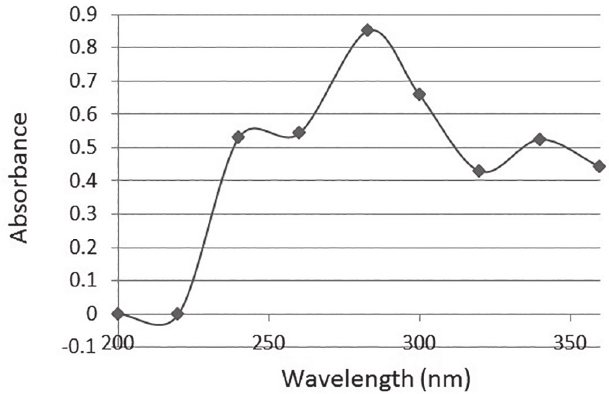
FIGURE 1 - UV spectrum of MFA (25 μg/mL) dissolved in DMSO at a wavelength range of 200-360 nm.